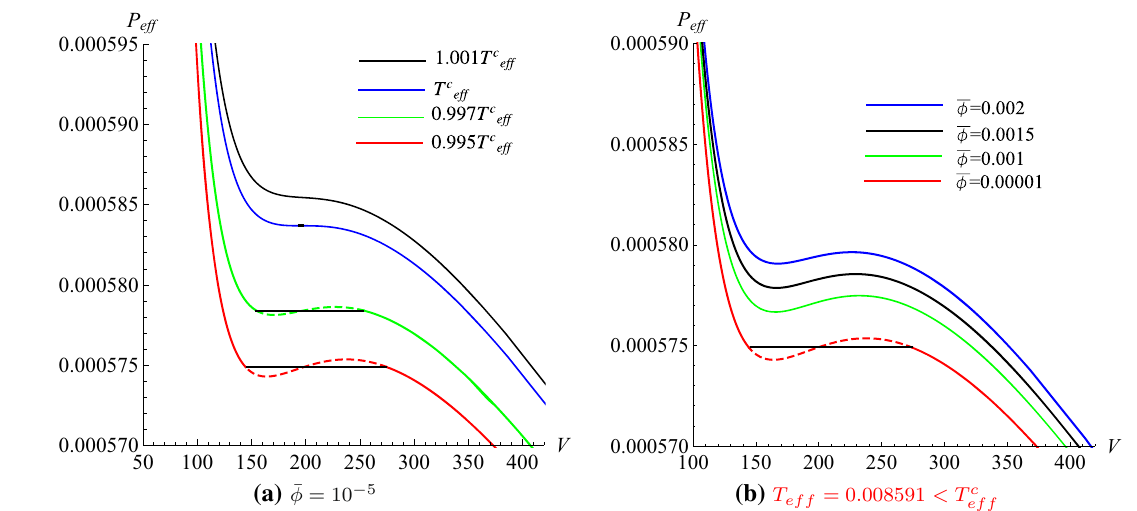
Fig. 1 P ef f − V with different non-linear corrections and different effective temperatures for the parameters k = 1 , q = 1